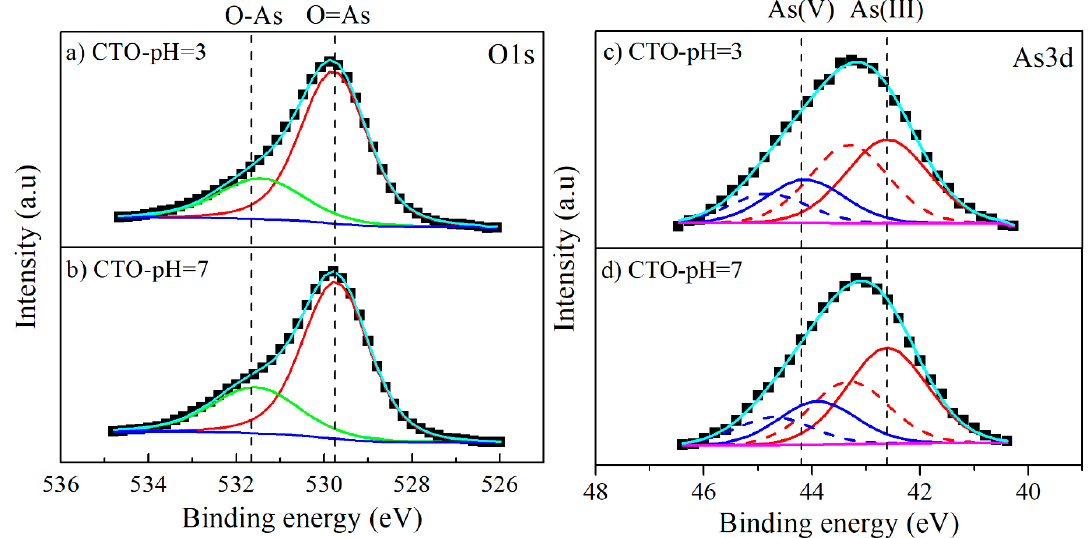
Figure 14. High-resolution XPS spectra of CTO after adsorption experiments at pH 3 and